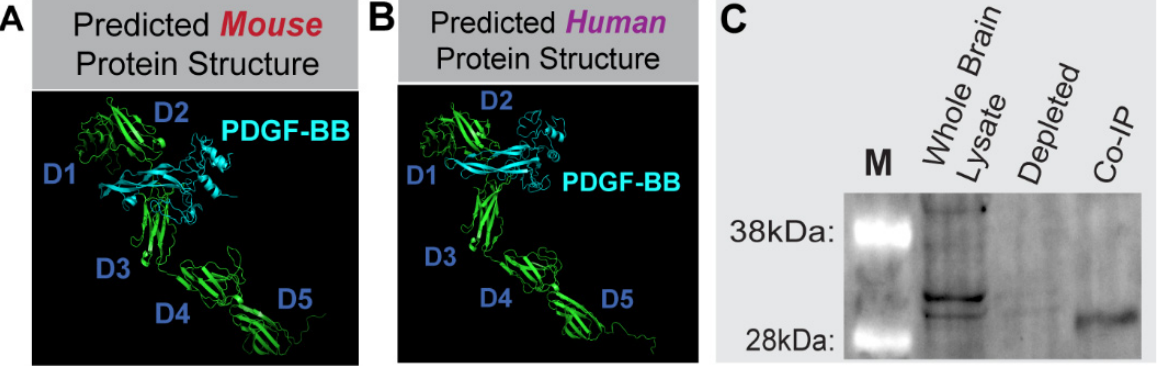
Figure 3. Soluble PDGFR β Engagement with PDGF-BB Ligand was Supported by Predicted Protein Models of Mouse and Human Splice Variants and sPDGFR β Co-Immunoprecipitation using PDGF-BB Capture. Protein models of mouse ( A ) and human ( B ) sPDGFR β variants including predictions for PDGF-BB (cyan) binding. “D” denotes major folding domains. ( C ) Immunoblot results (n = 1, P21 male) from the sPDGFR β co-IP, with “M” denoting size marker. Whole Lysate shown in Lane 2, the depleted fraction in Lane 3, and the co-IP elution labeled for PDGFR β in Lane 4. Note the distinct bands at ~32 kDa in the Whole Lysate and co-IP lanes.